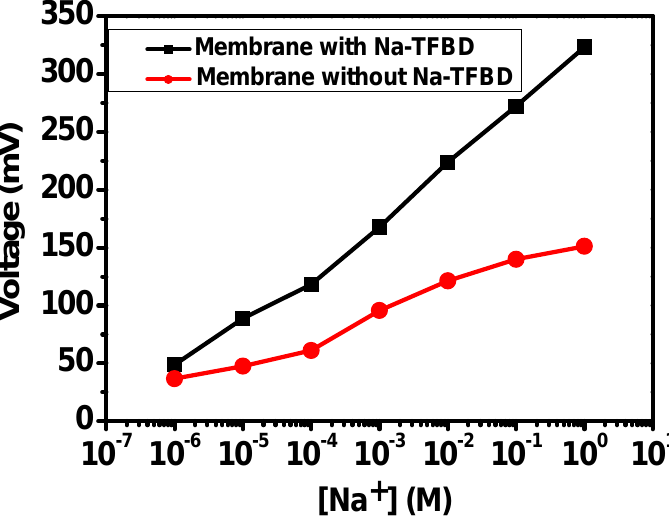
Figure 7. Sodium-sensing sensitivity of sodium-selective-membrane/anodized-ITO/ITO with Na-TFBD and without